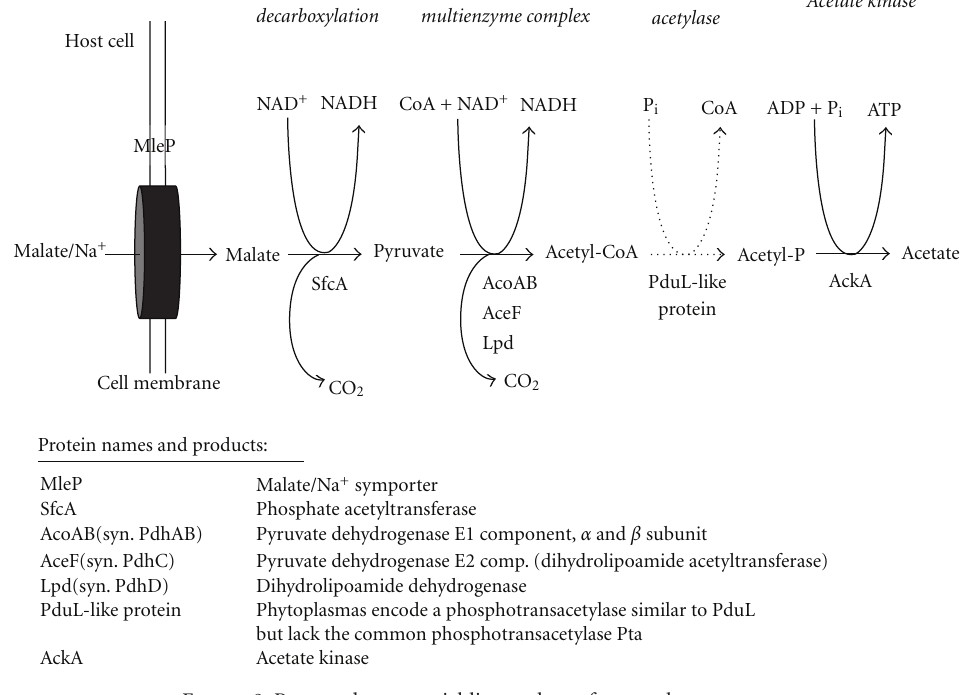
Figure 9: Proposed energy-yielding pathway from malate to